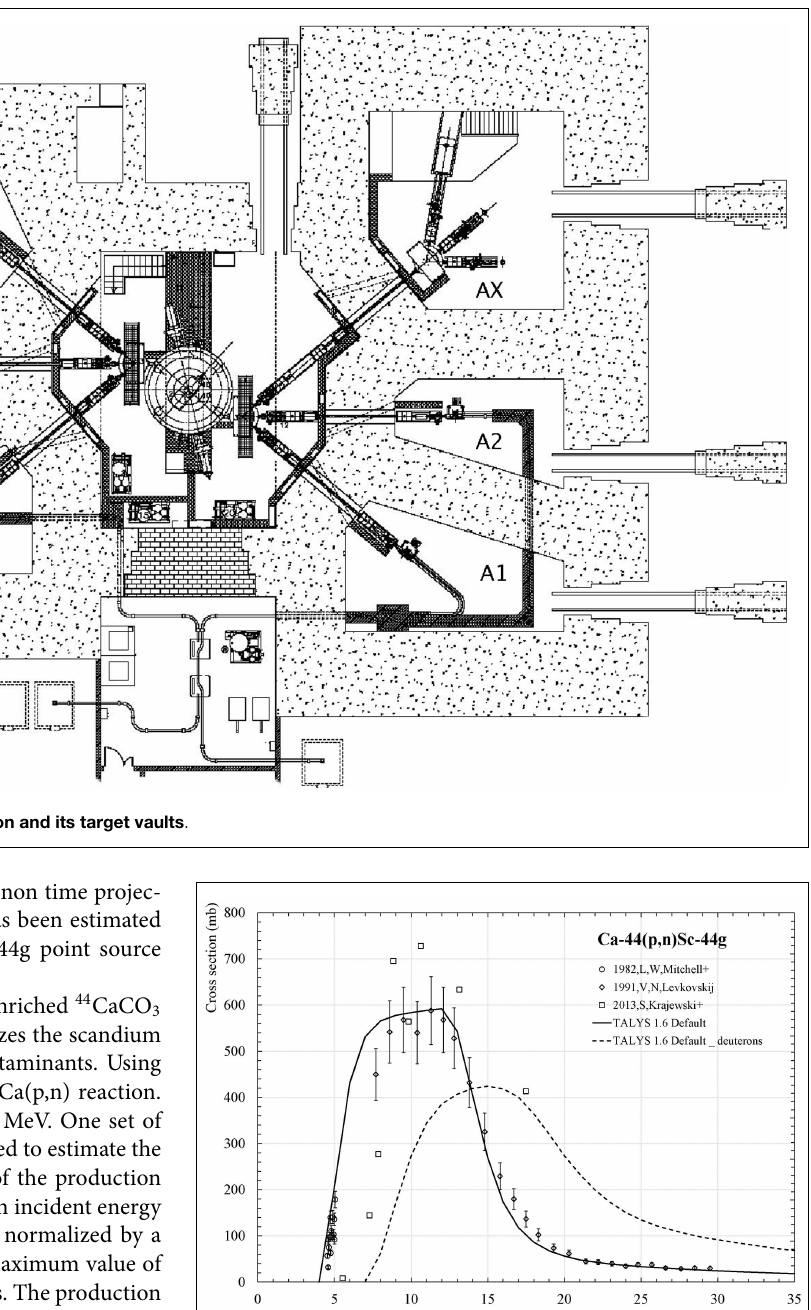
FIGURE 2 | Sc-44g production cross section for proton and deuteron-induced reaction on Ca-44 . The symbols correspond to the proton data of Levkovskij (8), the full line to TALYS calculation for protons and dashed line to TALYS calculation for deuterons. TALYS 1.6 has been used for these